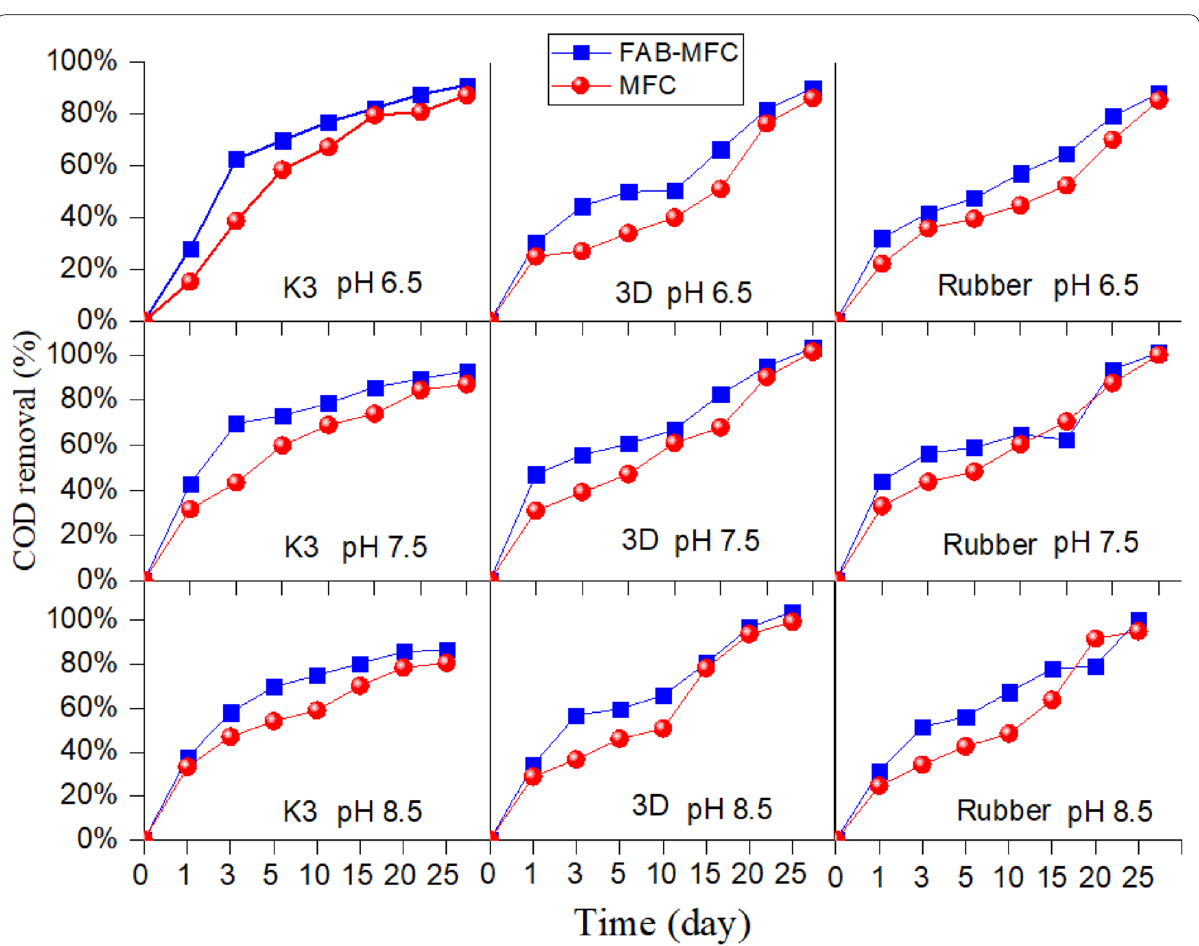
Fig. 8 COD removal efficiency of FAB-MFC and MFC using different MEJ-dish (K3, 3D, and rubber) at 27 ℃ and anodic pH 6.5, 7.5, and